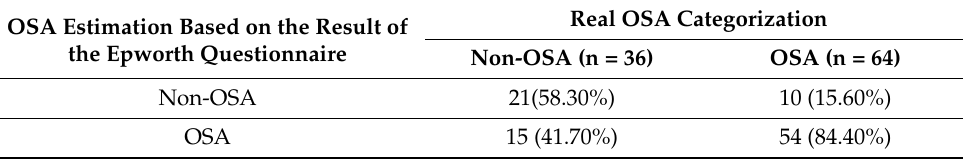
number of cases per 100 patients and the percentage distribution of scores within the non-OSA and OSA categories). OSA: obstructive sleep